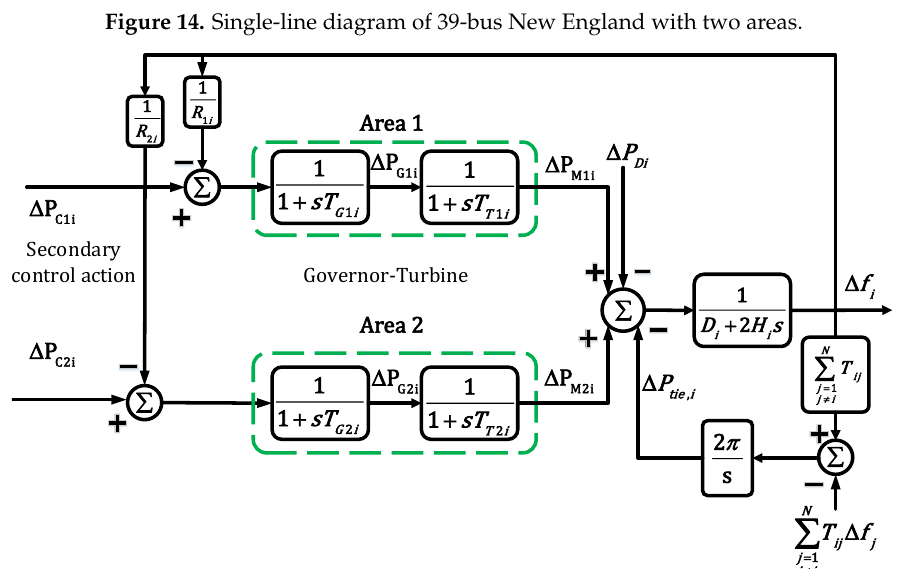
Figure 15. Block diagram of control area i = 1,2 for 39-bus test